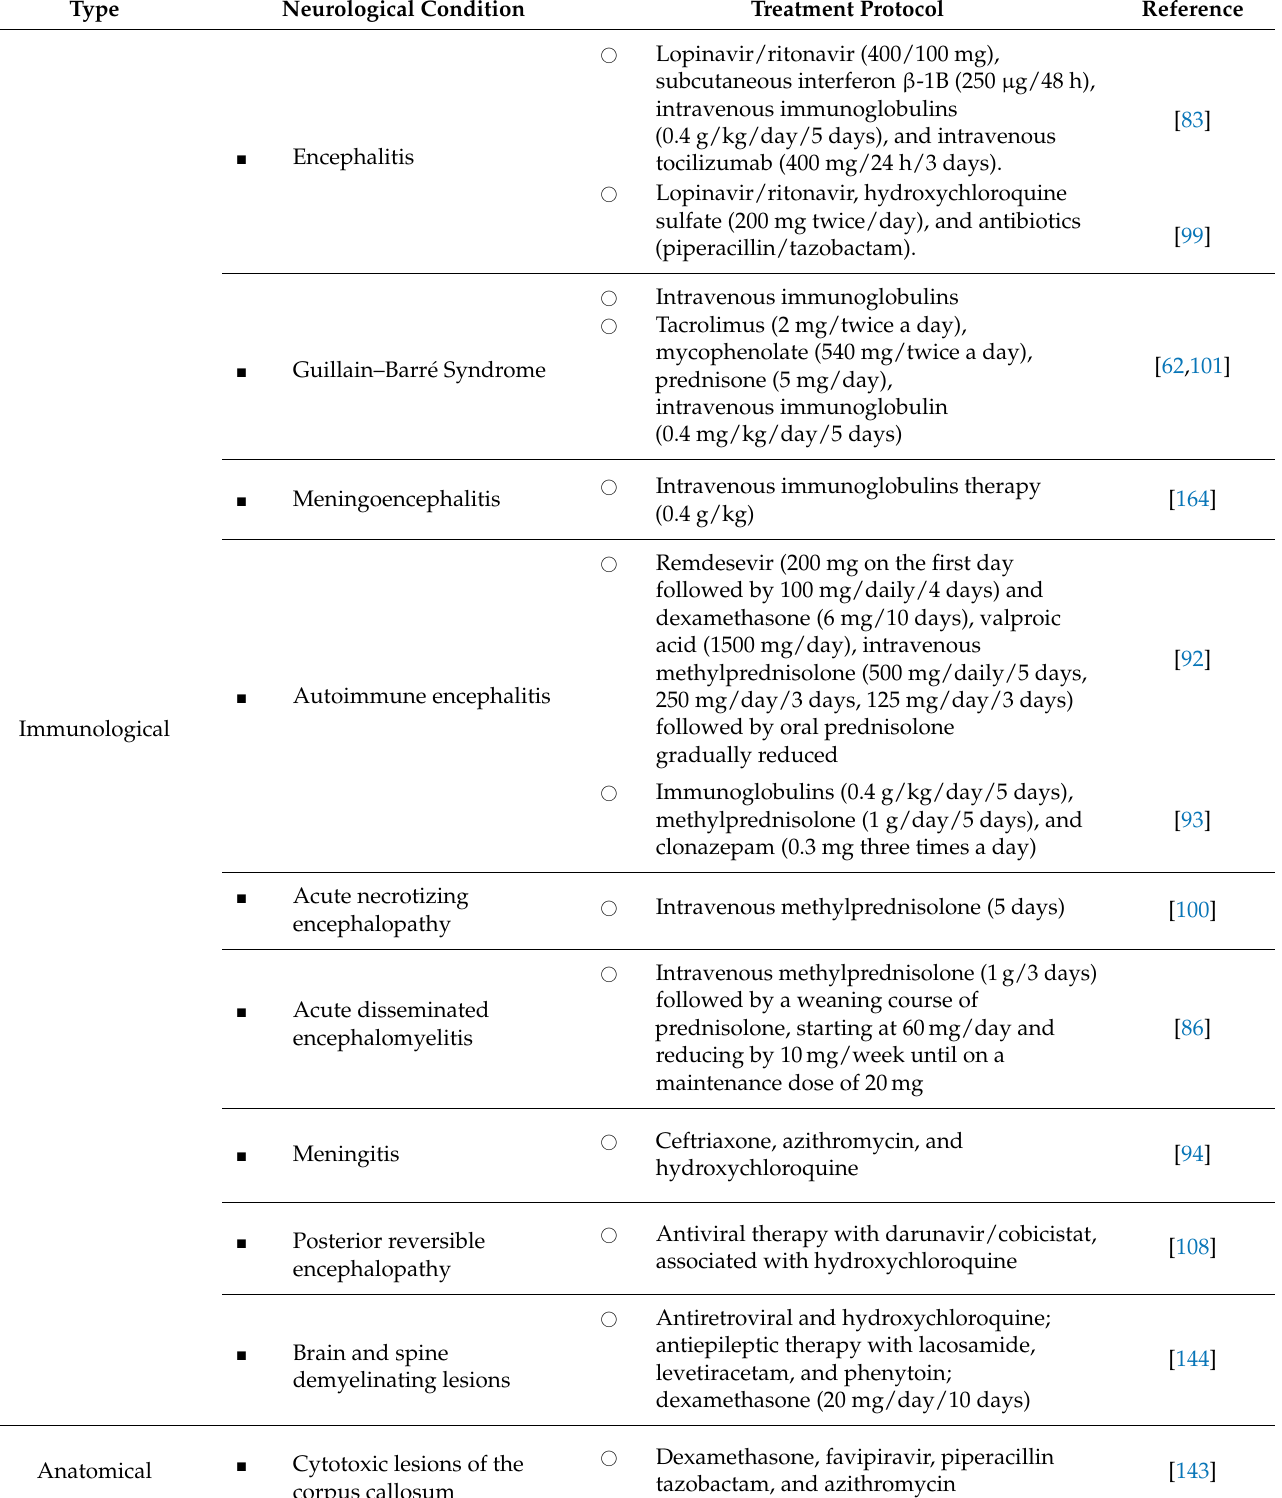
Table 2. Treatment protocols for neurological or psychiatric manifestations induced by COVID-19. Type Neurological Condition Treatment Protocol